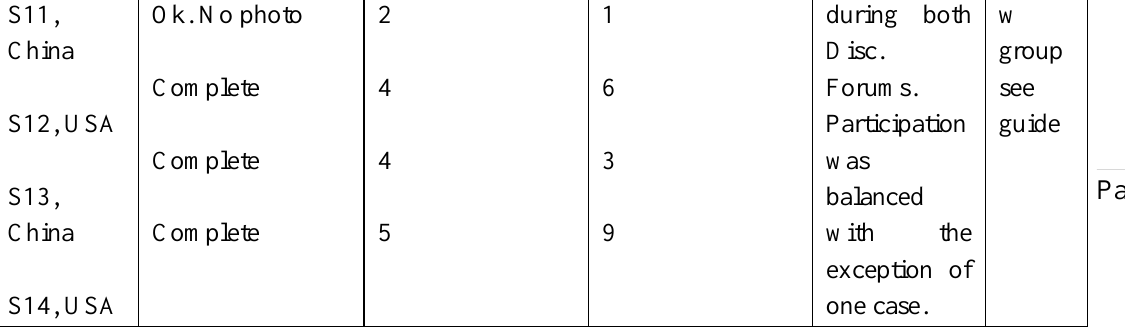
Note: The first column represents the groups and participants. The second column represents the Web page and photograph created or not by each participant. The third column represents an exercise about population in Bolivia and the number of interactions. The fourth column represents a theme related to the concept of carrying capacity and the number of interactions. The fifth column represents a brief comment sent by the instructors to each team. The sixth column indicates that each group can see a more detailed comment by accessing their own